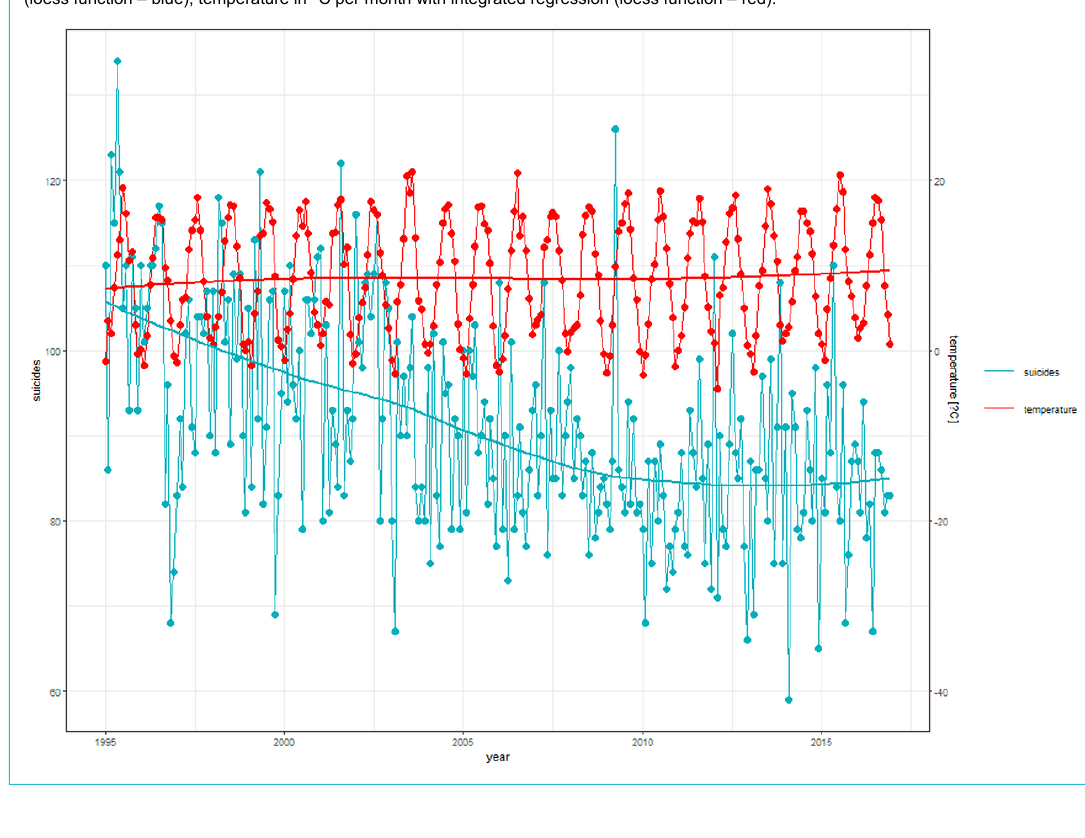
Figure S2: Time trends of suicides and temperature in Switzerland from 1995 to 2016. Suicide counts per month with integrated regression (loess function – blue); temperature in °C per month with integrated regression (loess function –